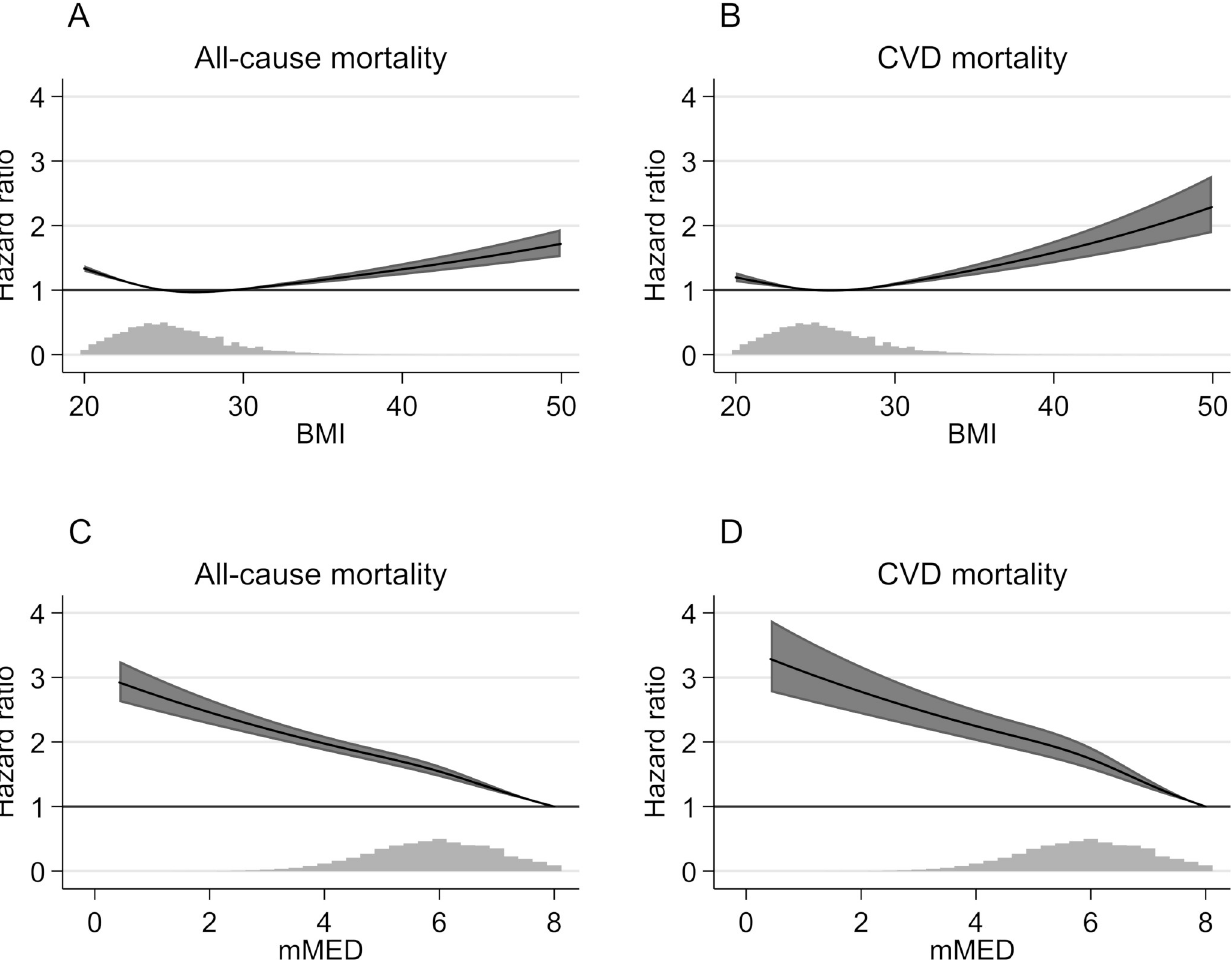
Fig 1. Association between BMI (A for all-cause mortality and B for cardiovascular mortality) and an mMED score (C for all-cause mortality and D for cardiovascular mortality) with mortality. The dark gray shaded regions in the figures correspond to 95% CIs, and the spike plots represent the distribution of BMI and mMED scores, respectively. Assessed by multivariable-adjusted HRs using of Cox regression analysis and restricted cubic splines, with a BMI of 25 kg/m 2 and mMED score of 8 units as references. HRs adjusted for sex, age (splines with 2 knots), educational level ( � 9, 10–12, > 12 years, other), living alone (yes or no), leisure time physical exercise during the past year ( < 1 h/w, 1 h/w, 2–3 h/w, 4–5 h/w, > 5 h/w), walking/cycling (almost never, < 20 min/d, 20–40 min/d, 40–60 min/d, 1–1.5 h/d, > 1.5 h/d), height (splines with 2 knots), energy intake (splines with 2 knots), smoking habits (current, former, never), Charlson’s weighted comorbidity index (continuous; 1–16), and diabetes mellitus (yes/no). BMI, body mass index; CI, confidence interval; CVD, cardiovascular disease; HR, hazard ratio; mMED, modified Mediterranean-like